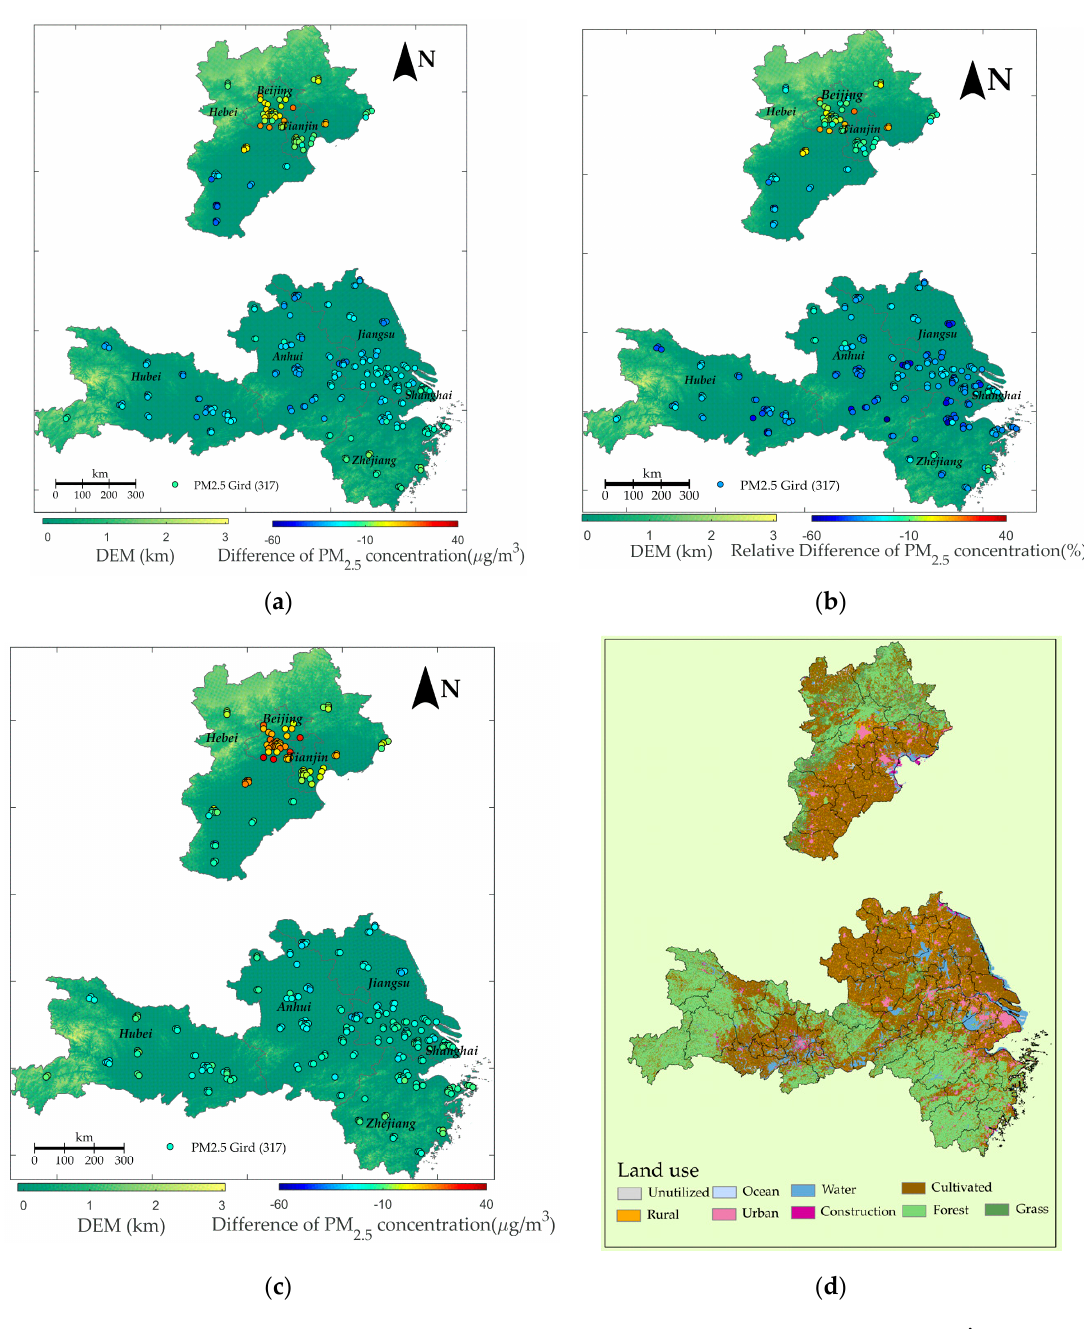
Figure 4. Spatial distribution of ( a ) the mean di ff erence of PM 2.5 under SD and NSF ( PM sd − ˆ PM sd | nsf ); ( b ) the mean relative di ff erence of PM 2.5 under SD and NSF (( PM sd − ˆ PM sd | nsf ) / ˆ PM sd | nsf × 100); ( c ) the mean di ff erence of PM 2.5 under SD and NC ( PM sd − ˆ PM sd | nc ); and ( d ) land uses of Beijing–Tianjin–Hebei (BTH), Yangtze River Delta (YRD), and Hubei. The bluer the sites are, the smaller the difference is.